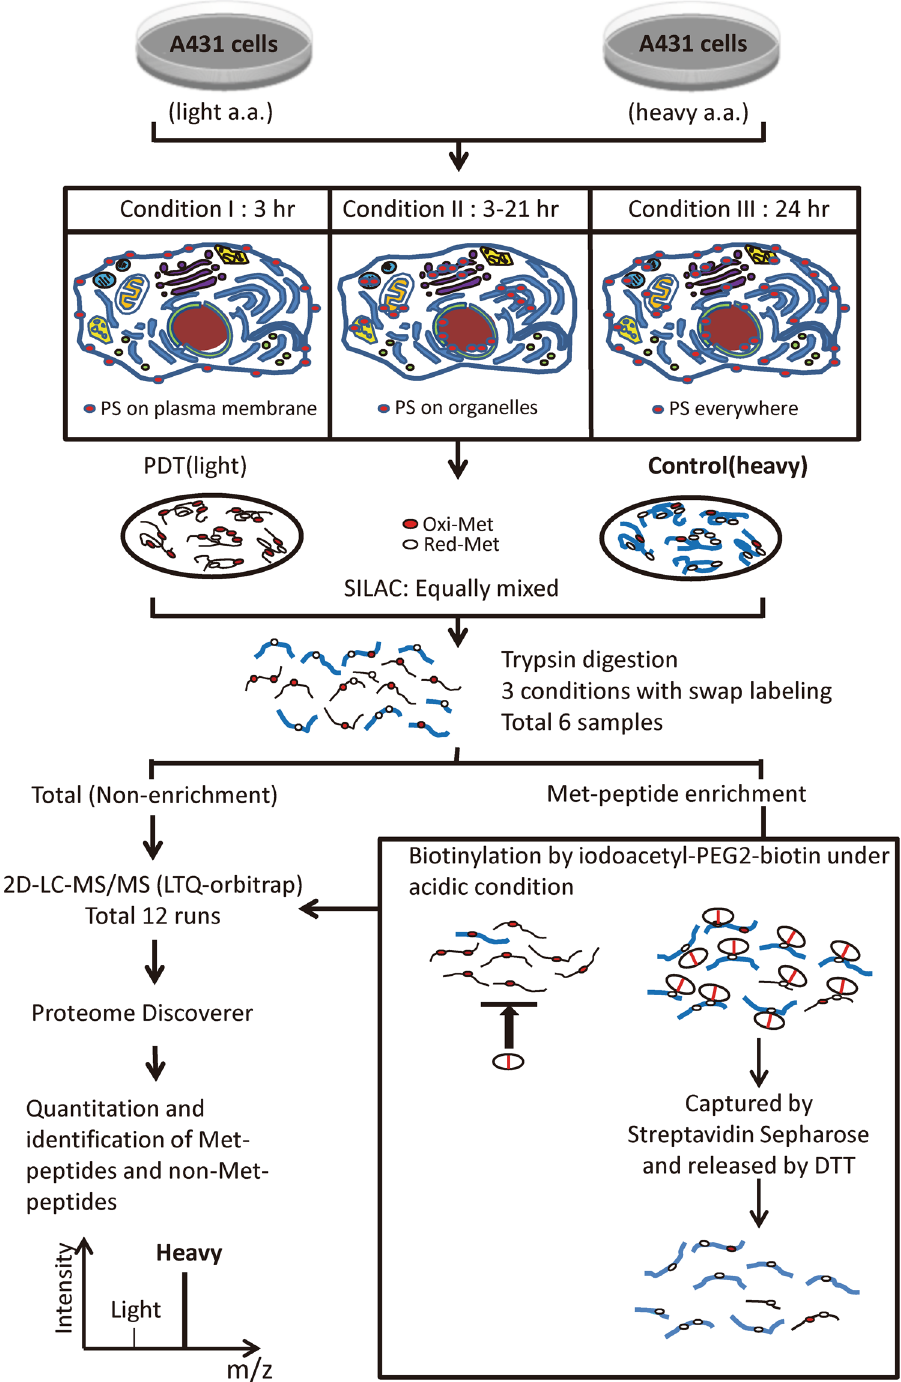
Figure 2. Workflow for Met oxidation profiling in A431 cells treated with different Photofrin-PDT regimens. SILAC-labeled A431 cells were preloaded with Photofrin (as photosensitizer, PS) under three different incubation conditions (conditions I-III), and treated with or without laser irradiation to generate paired control and PDT cell groups, respectively. Equal amount of protein extracts from the control and PDT groups were mixed at a 1:1 ratio and digested with trypsin. Each digested sample was divided into two parts; one part was directly analyzed by 2D-LC-MS/MS (LTQ-Orbitrap), while the other was subjected to iodoacetyl-PEG2-biotin- mediated Met-peptide enrichment, followed by the same 2D-LC-MS/MS analysis. A label-swap replication of the SILAC experiment was applied to each condition. The Protein Discoverer software (Thermo Scientific) was used to combine and analyze the MS data from all 12